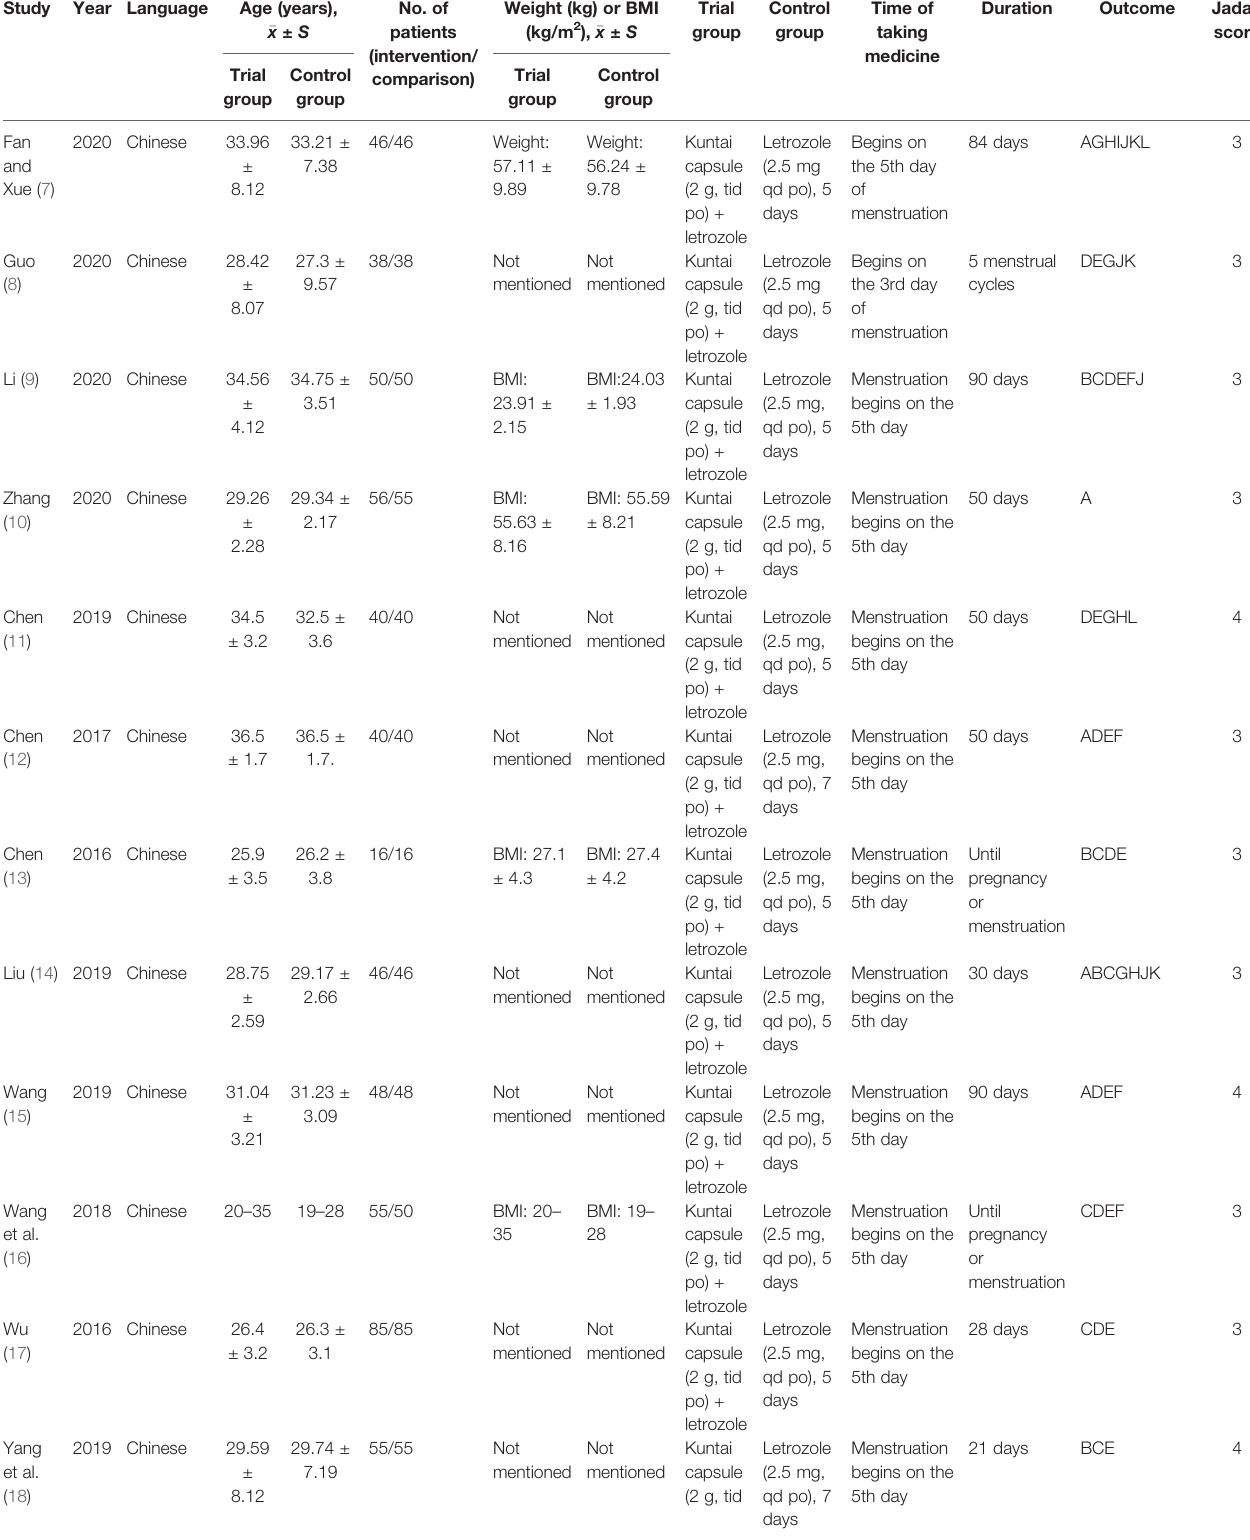
TABLE 1 | Basic features of the included